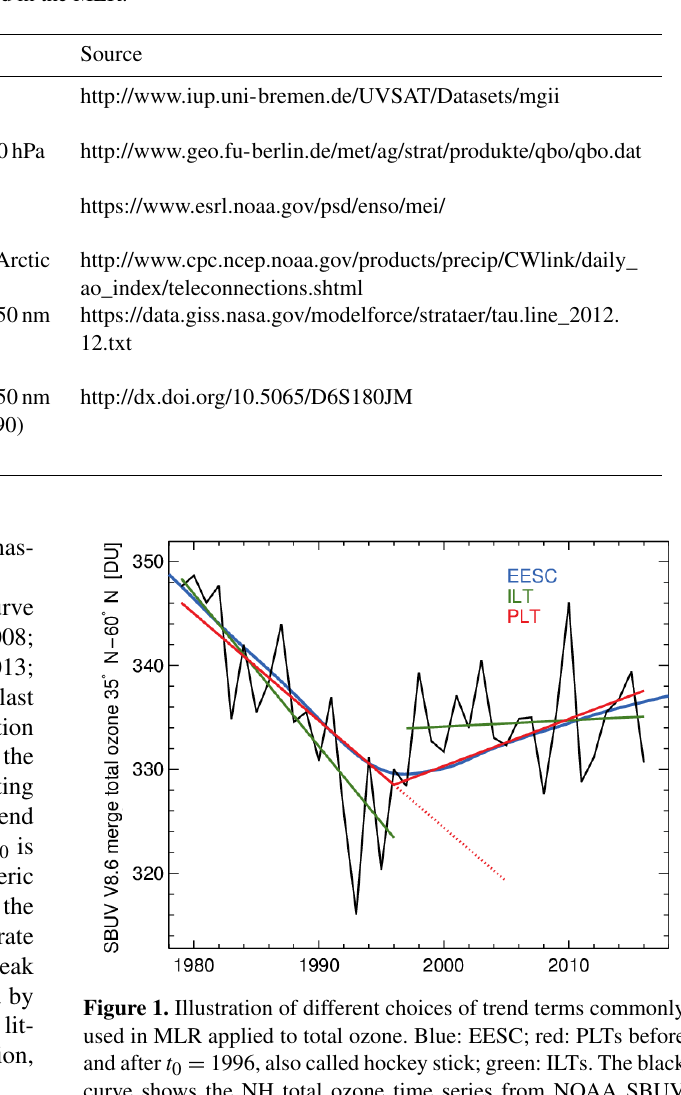
Table 2. Sources of explanatory variables/proxy time series used in the MLR.